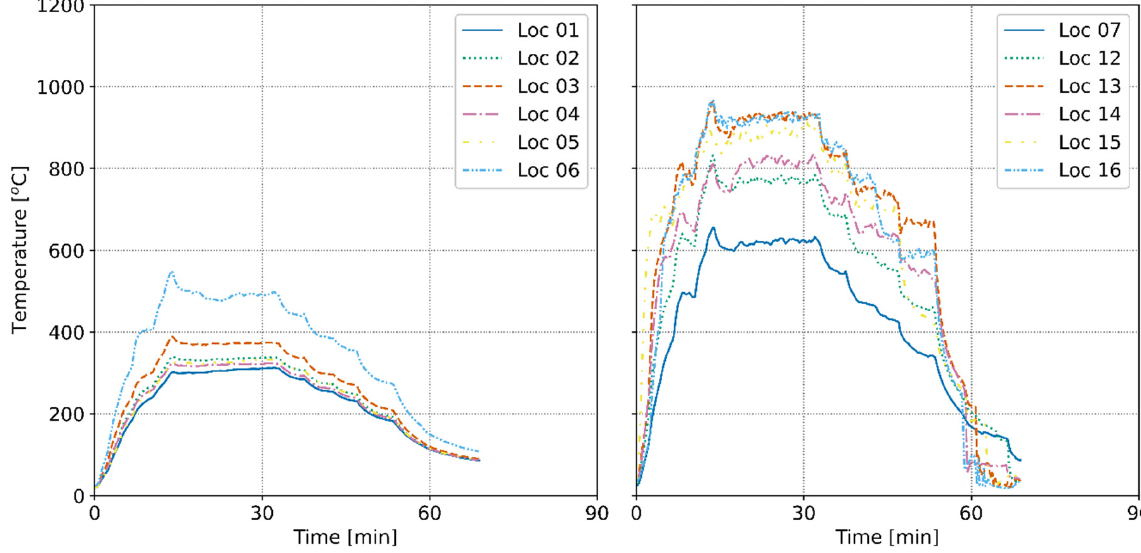
Figure 10. Surface temperatures for Experiment 1 at different locations.